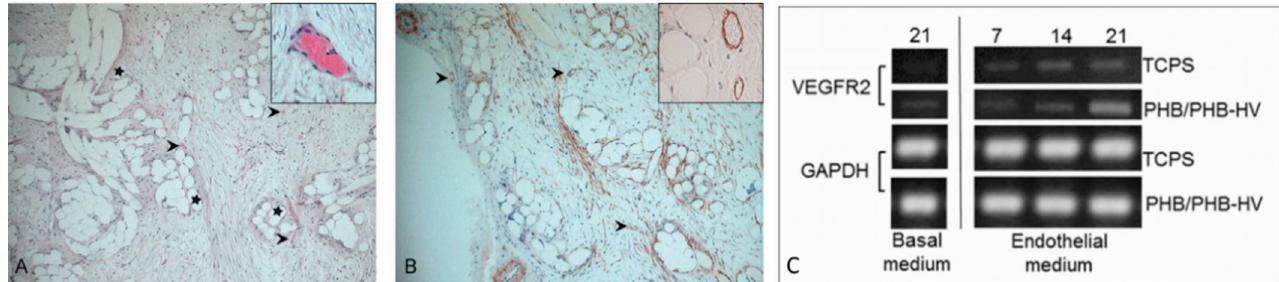
Figure 11. Vascularization in PHBHV-based fiber scaffolds: ( A , B ) PHBHV fibers after implantation in nude rats, arrows indicate the blood vessels, stars point to scaffold fibers [173]: ( A ) hematoxylin/eosin staining, and ( B ) 1A4 actin staining, reprinted and adapted under John Wiley and Sons Copyright Clearance Center (license number 5170801144911); and ( C ) PHB/PHBHV fibers cultured in vitro with adipose-derived MSCs: expression of VEGFR-2 as an endothelial marker [172], reused under Creative Commons Attribution License.